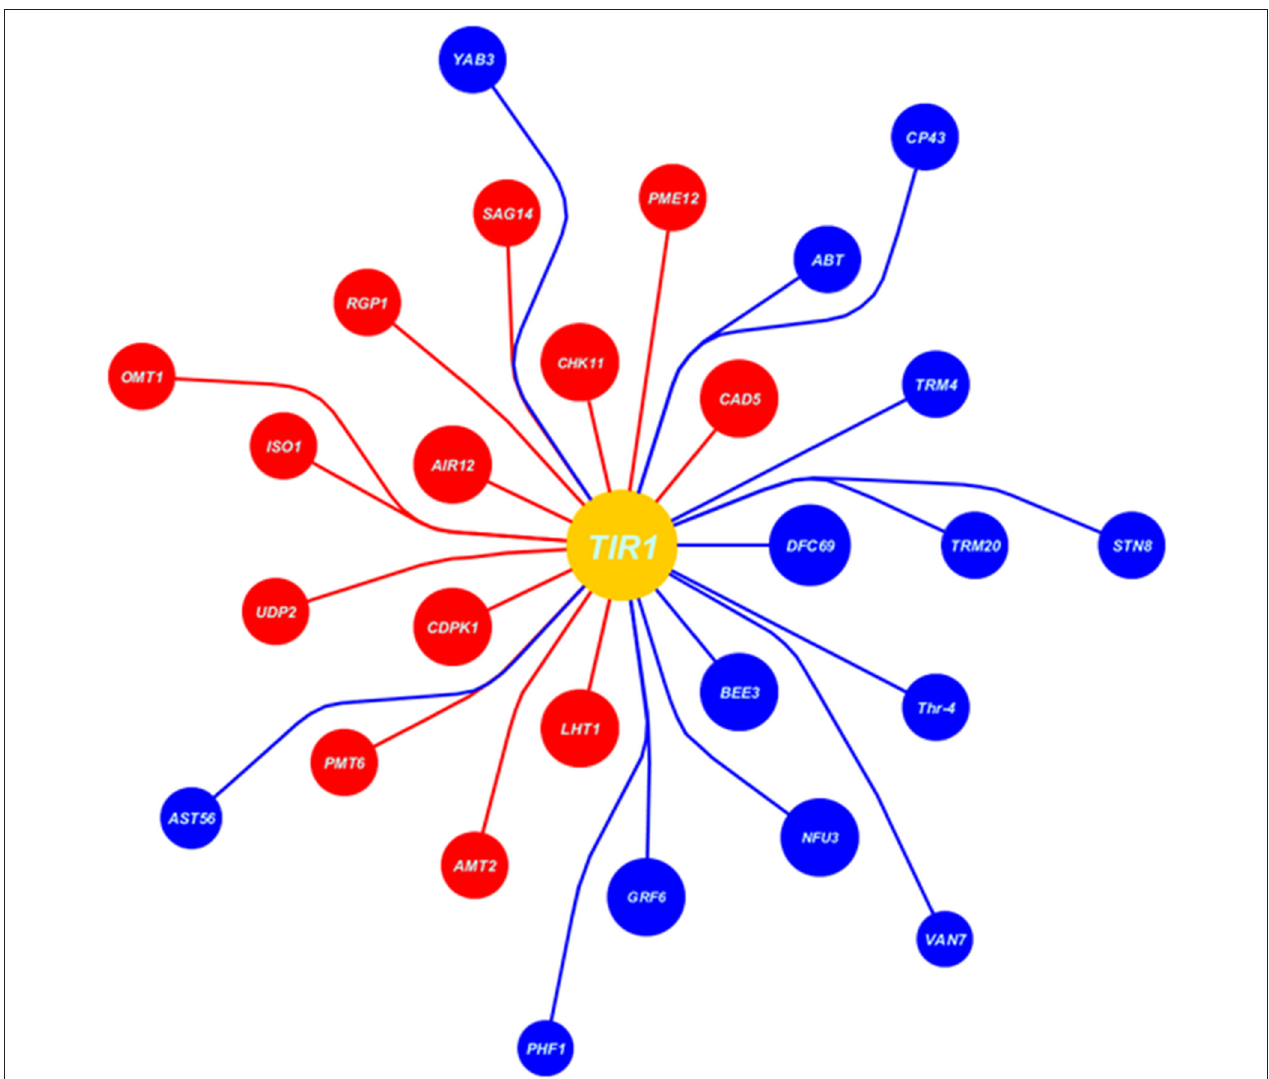
FIGURE 7 | Data extracted from Expression Angler (2016) showing the set of co-expressed genes with TIR1 (auxin signaling gene) under biotrophic stress ( Erysiphe orontii ) as blue balls indicates the downregulated genes, while red indicates the upregulated genes. Moreover, the area of the ball shows the R -value of co-expressed gene, larger the R -value larger the area of the ball and nearer to the TIR1